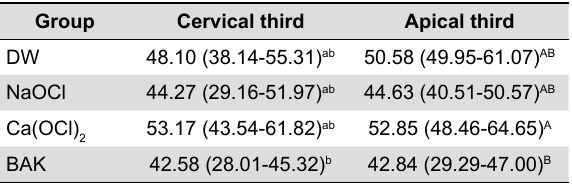
Table 4- Contact angle measurement in cervical and apical thirds (median, maximum and minimum values)